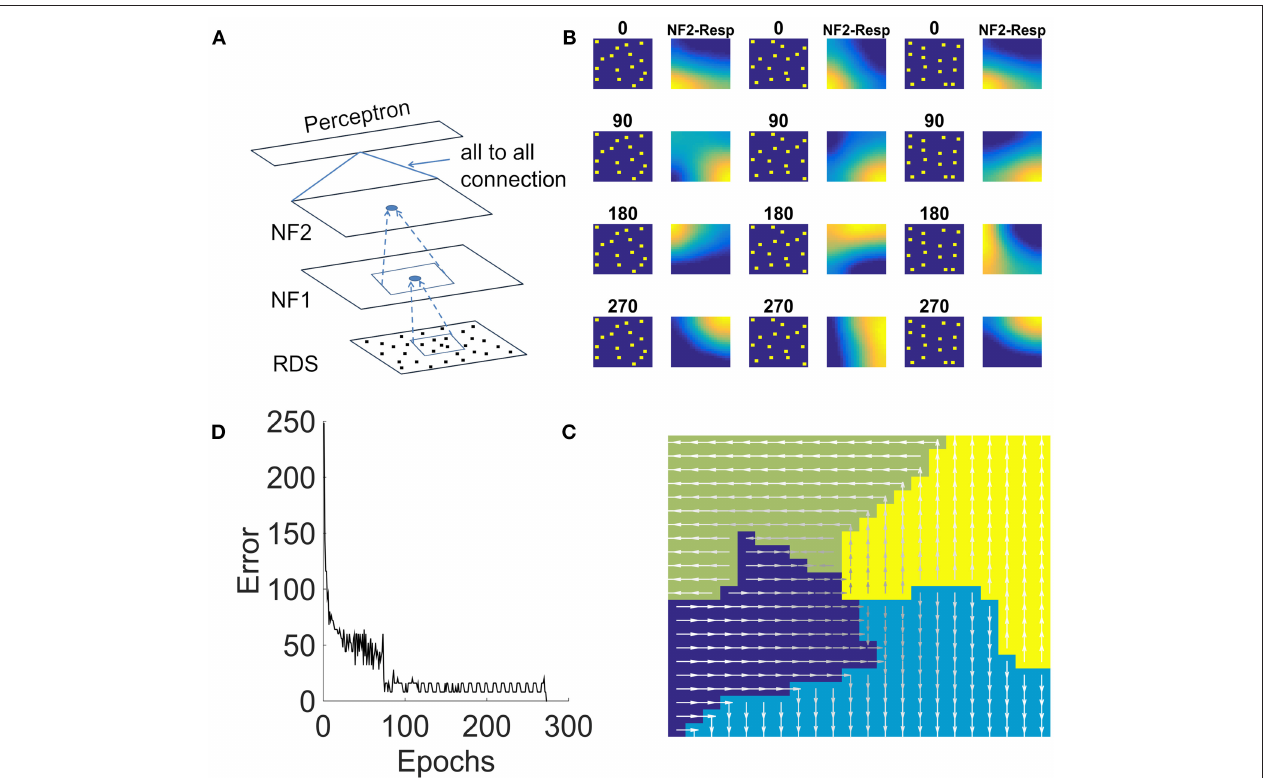
FIGURE 8 | NF2 response to translational random dot stimuli. (A) Proposed 2NFs network : both NFs are trained using unsupervised asymmetric Hebbian rule and the third single layer perceptron is trained using backpropagation. Random dots stimulus (RDS) is created by placing tiny squares of size 2 × 2 pixel (assumed as dots) on 32 × 32 pixel size grid randomly with a constraint that each 8 × 8 pixel grid can accommodate only one dot. Thus, 16 dots are placed randomly and moved dots coherently in 4 directions: 0, 90, 180, 270 ◦ to create translational flow sequences. Thus, each dot configuration creates 4 sequences for the train set. First, third and fifth columns in (B) shows three different dot configurations moving in the same direction. Second, fourth and sixth columns show the NF2 activity, when these configurations moved in 4 directions. Here the neurons encode the coherent motion direction, independent of the precise dot configuration. (C) It represents the translational flow selectivity map in response to the train set consisting of 80 sequences. The arrow direction indicates the neurons preferred direction of motion to the translational flow stimuli. (D) Error plot obtained while training single layer perceptron using NF2 responses of the train set. Single layer perceptron has an input layer and an output layer; the weights (all-to-all connections) between them are trained using regular backpropagation. Perceptron took nearly 300 epochs to learn the